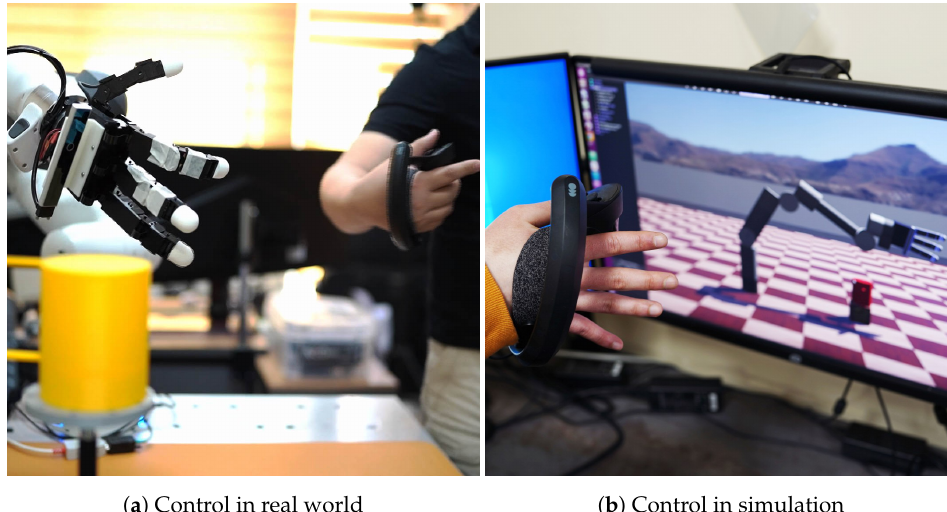
Figure 8. Hand trajectory recording using the VR